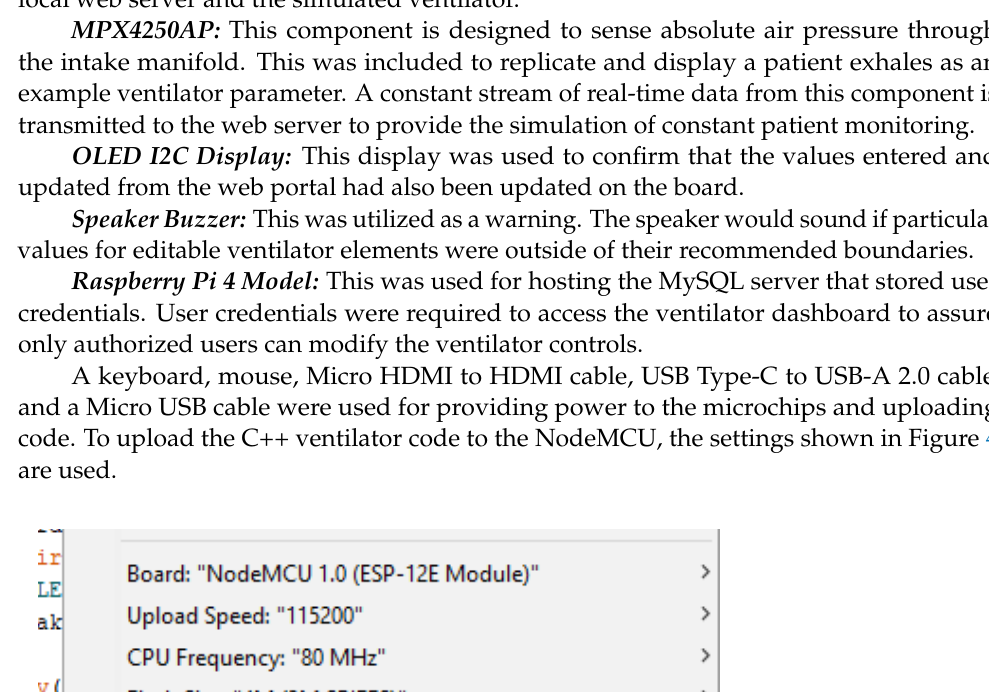
Figure 5. NodeMCU connections. 5.3. Implementation and Experiment Execution To start the web server, a Python script must be manually executed on the Raspberry Pi. This script includes imports from SQLAlchemy, a library that facilitates the communication between Python programs and databases, and Flask, a micro web framework written in Python. This allows for the credentials entered into the login portal to be validated against the MySQL database containing approved user credentials. Figure